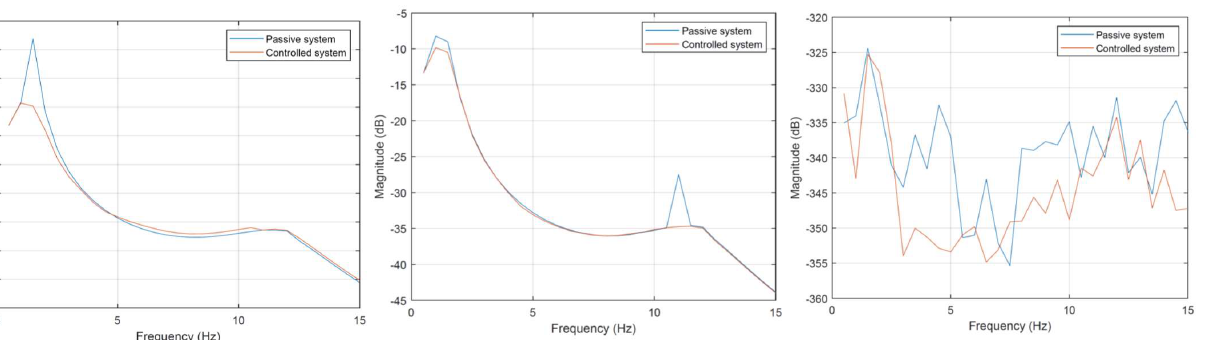
Figure 14. Vibration transmissibility characteristics for excitation of the rear axis for both wheels simultaneously. Displacement of the center of mass—left characteristic, pitch angle—central char- acteristic, roll angle—right characteristic.